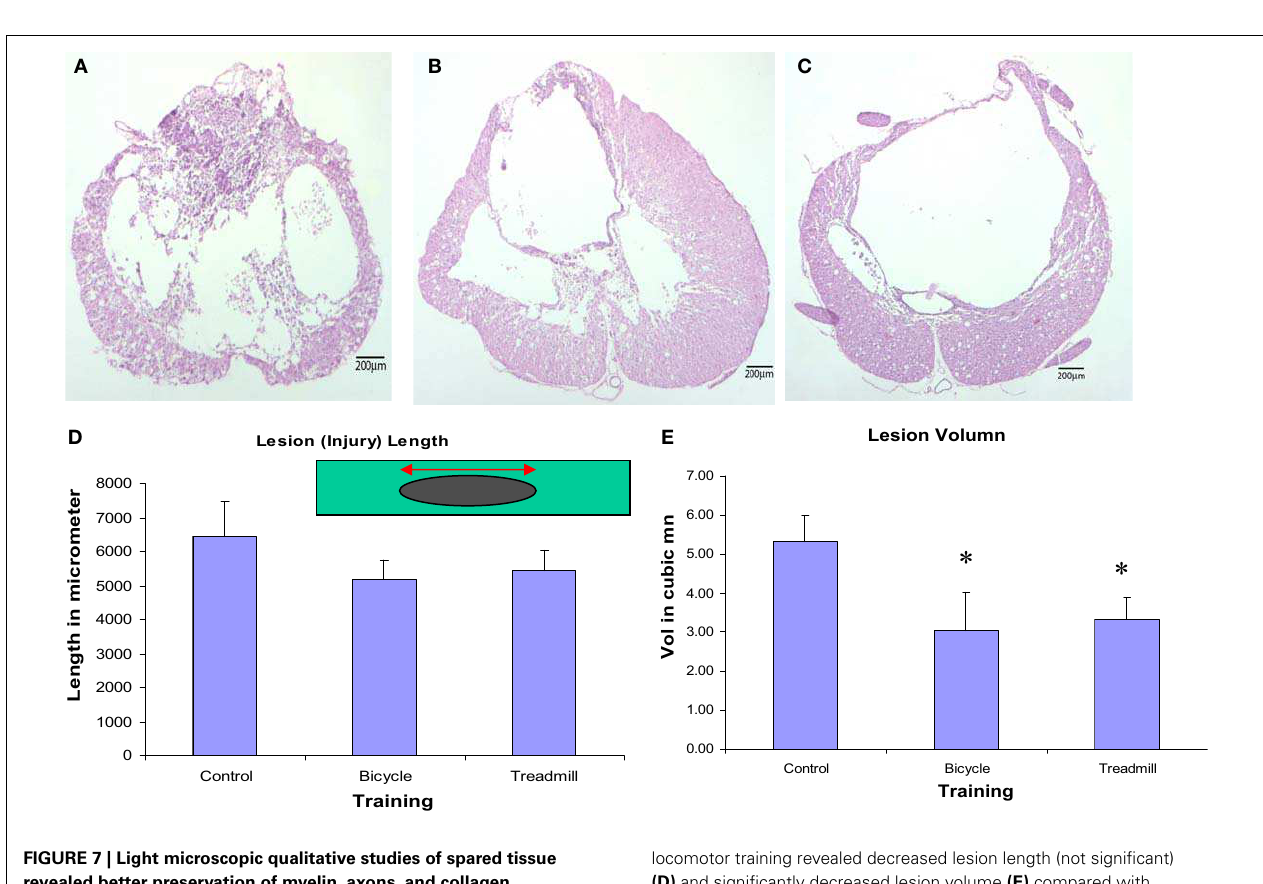
FIGURE 7 | Light microscopic qualitative studies of spared tissue revealed better preservation of myelin, axons, and collagen morphology in locomotor trained animals (B,C) compared to contused untrained control (A). Animals treated with either type of